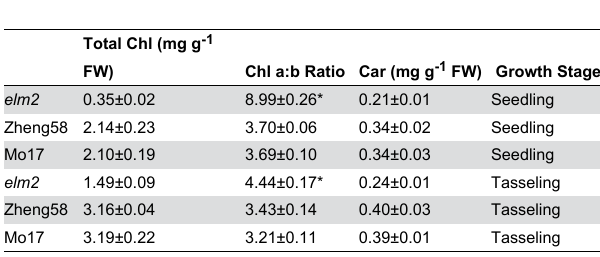
Table 2. Pigment